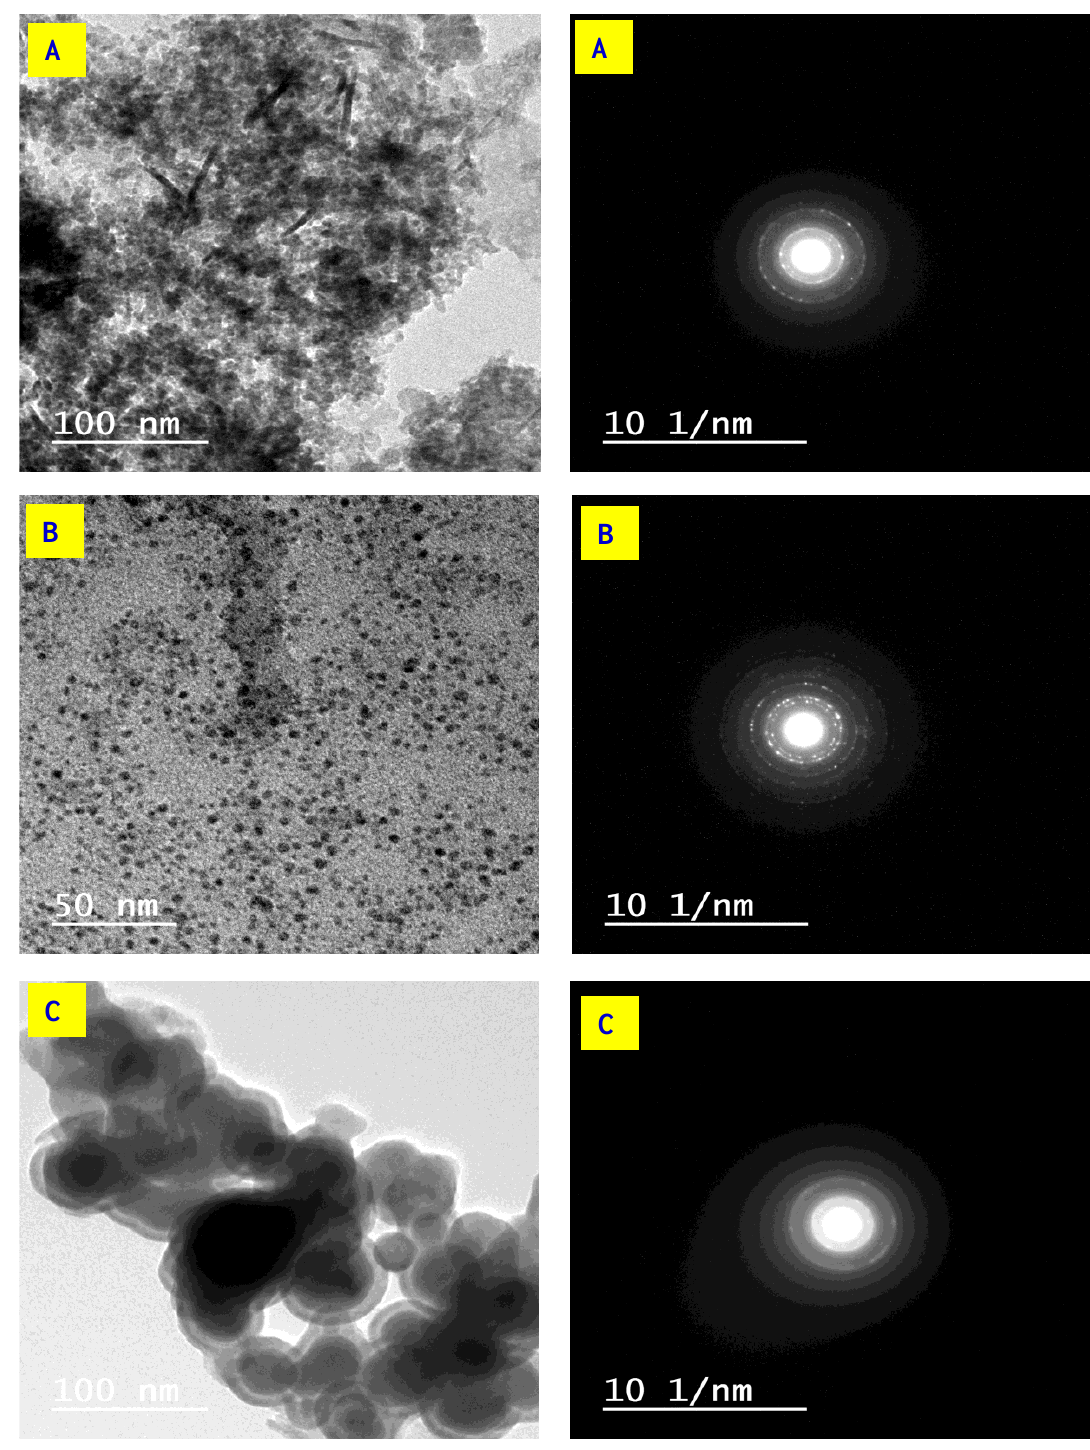
Figure 4. transmission electron microscope (TEM) and selected area diffraction pattern (SAED) of ( A ) PAC/NiONPs, ( B ) PAC/CuONPs and ( C ) PAC/Fe 3 O 4 NPs nanocomposites.